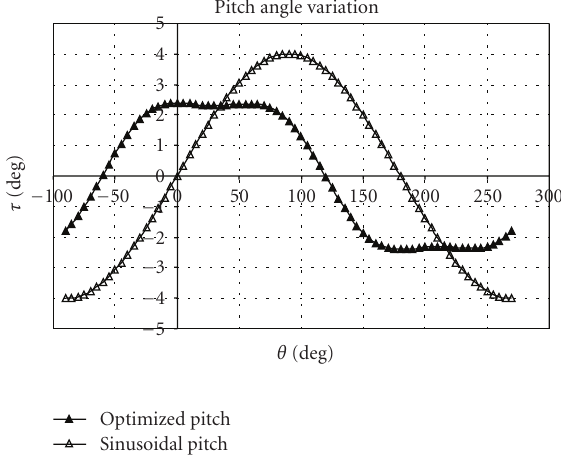
Figure 5: Optimal variation of the blade pitch angle.